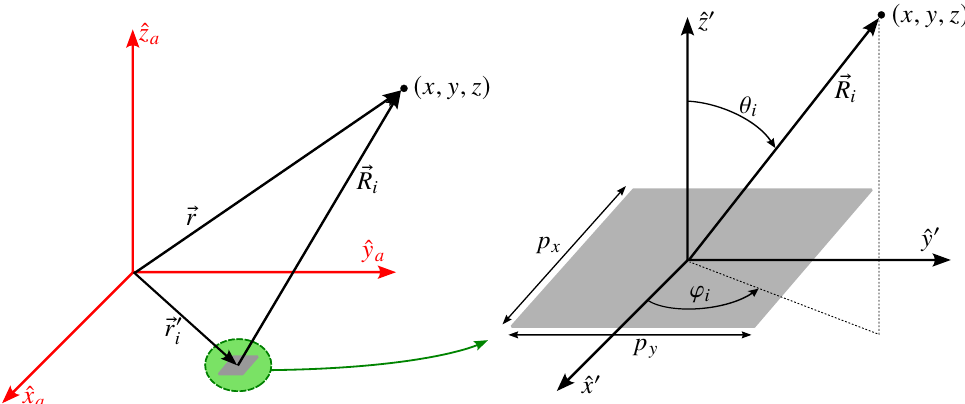
Figure 2. The definition of the angles θ i and ϕ i for the computations of the far field radiated by an array element are defined in the element coordinate system ( ˆ x (cid:48) , ˆ y (cid:48) , ˆ z (cid:48) ) , which is the same as the ACS but translated by (cid:126) r i (cid:48)